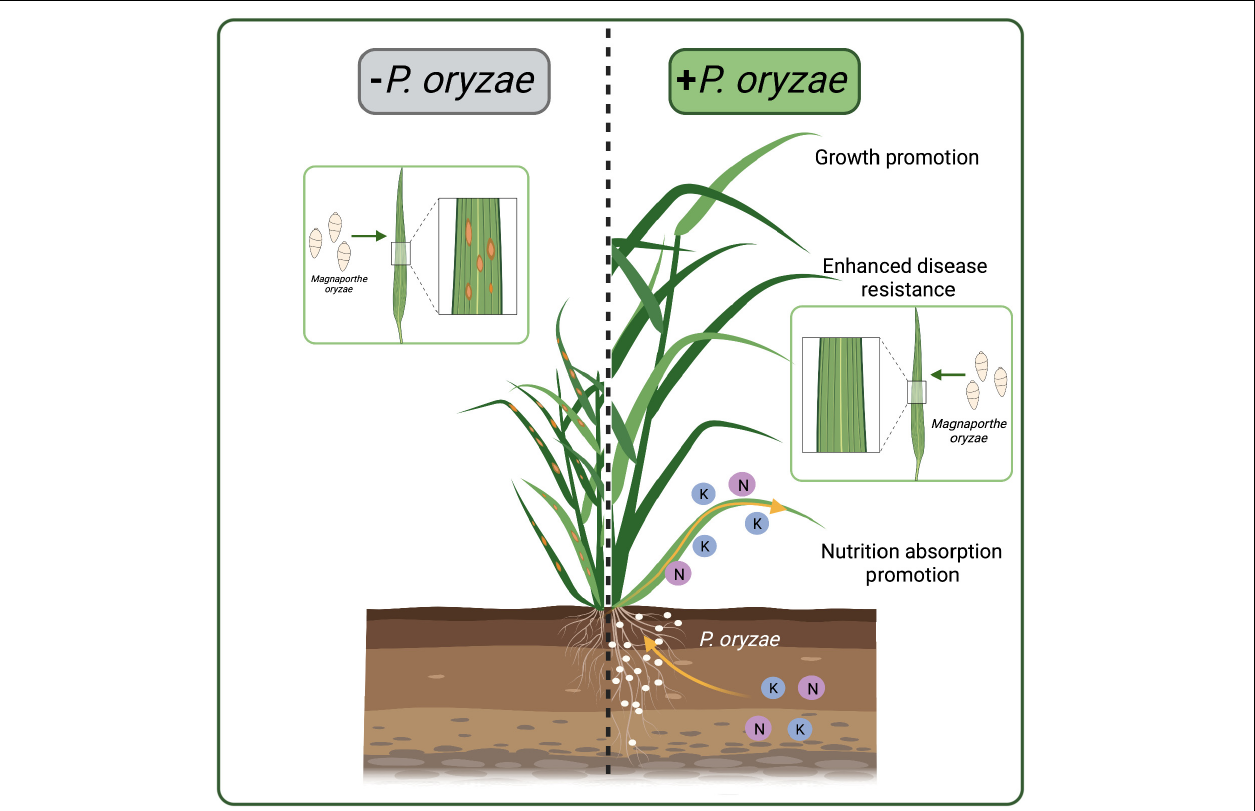
FIGURE 8 | Schematic representations of rice colonized by P. oryzae . P. oryzae promoted the absorption of N and K elements, promoted rice growth, and enhanced the resistance to rice blast. The white dots represent P. oryzae